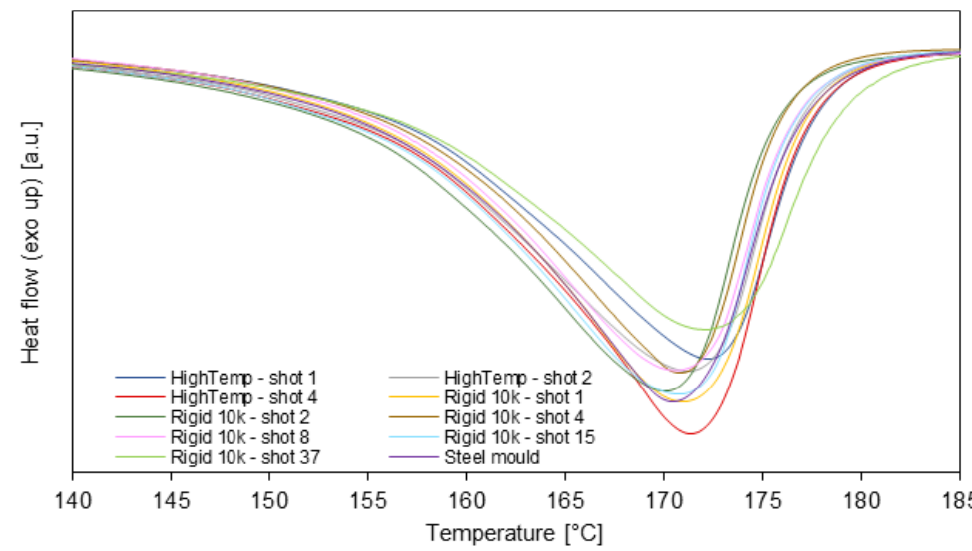
Figure 9. Comparative highlight of the melting interval from selected DSC thermograms obtained during the heating step for PP moulded in different moulds and at different shots.